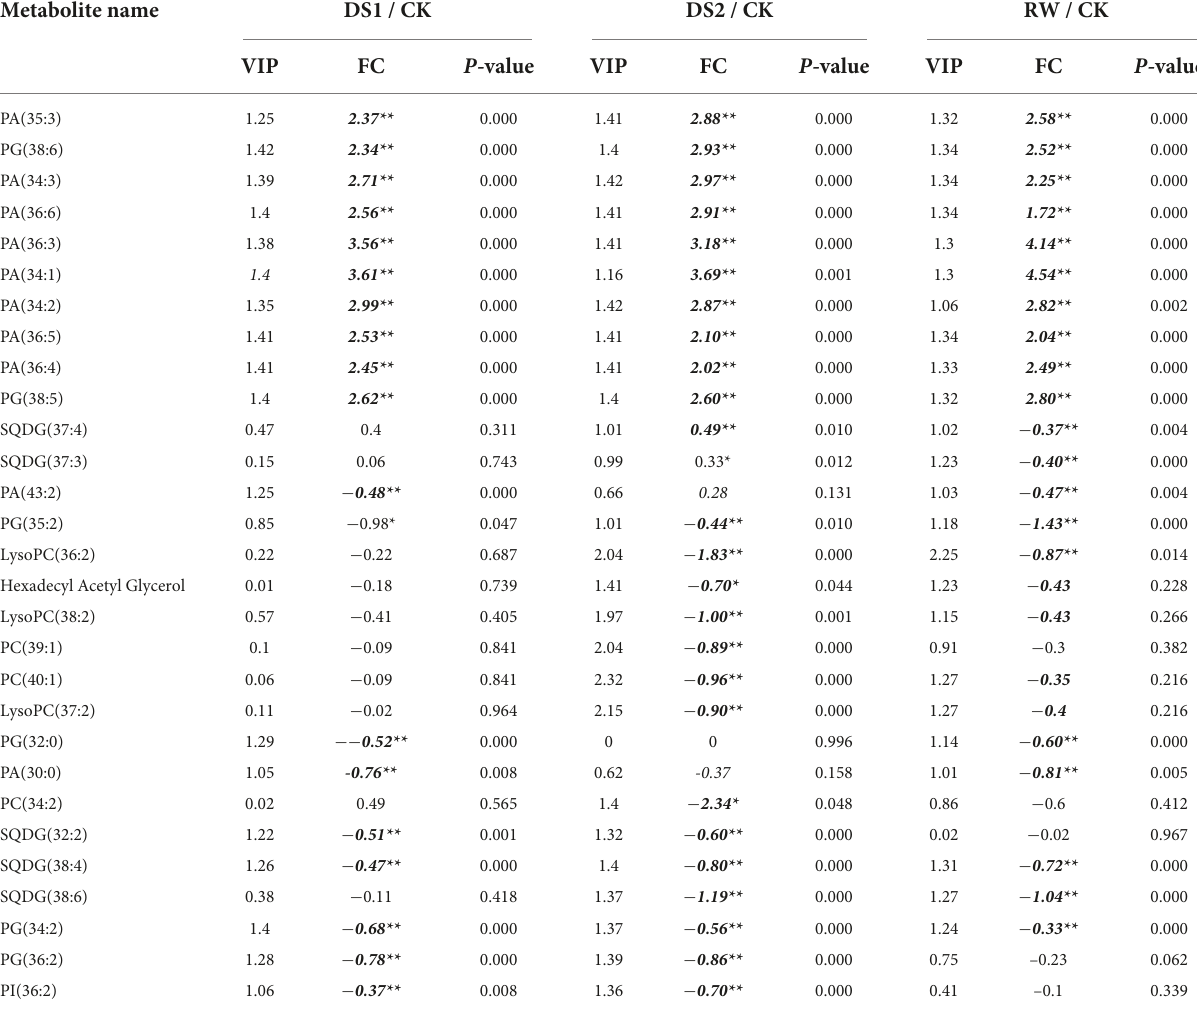
TABLE 2 Fold changes (FC) of significantly differential lipids in leaves of C. sinensis cv. Ruixue in response to drought